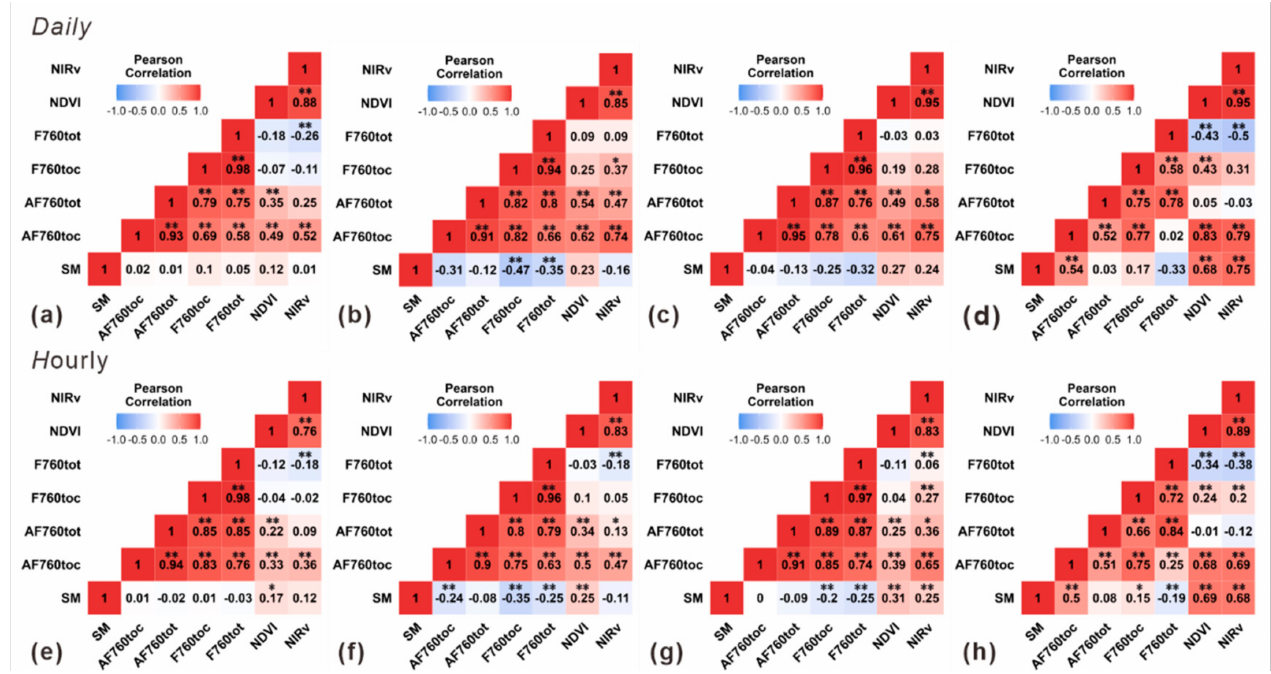
Figure 9. Heatmap of the correlation matrix generated by the Pearson correlation coefficient shows the relationships of SM with SIF and VI at seasonal scale (upper panel) and diurnal scale (lower panel) in ( a , e ) plot 1, ( b , f ) plot 2, ( c , g ) plot 3, and ( d , h ) plot 4. Significance levels of p < 0.05, p < 0.01, and p < 0.001 are indicated by *, **, and ***,